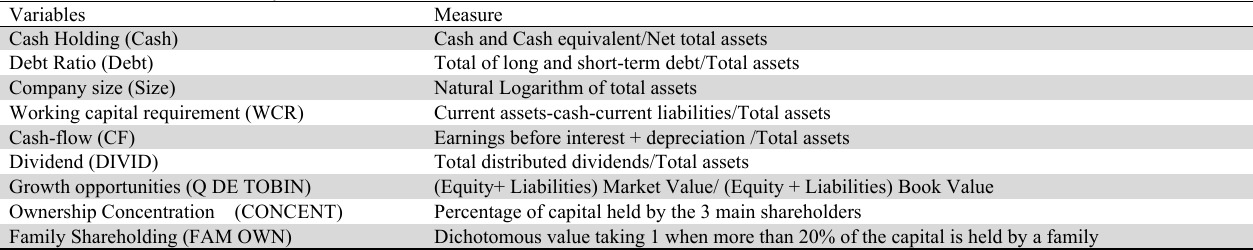
Variable definition summary